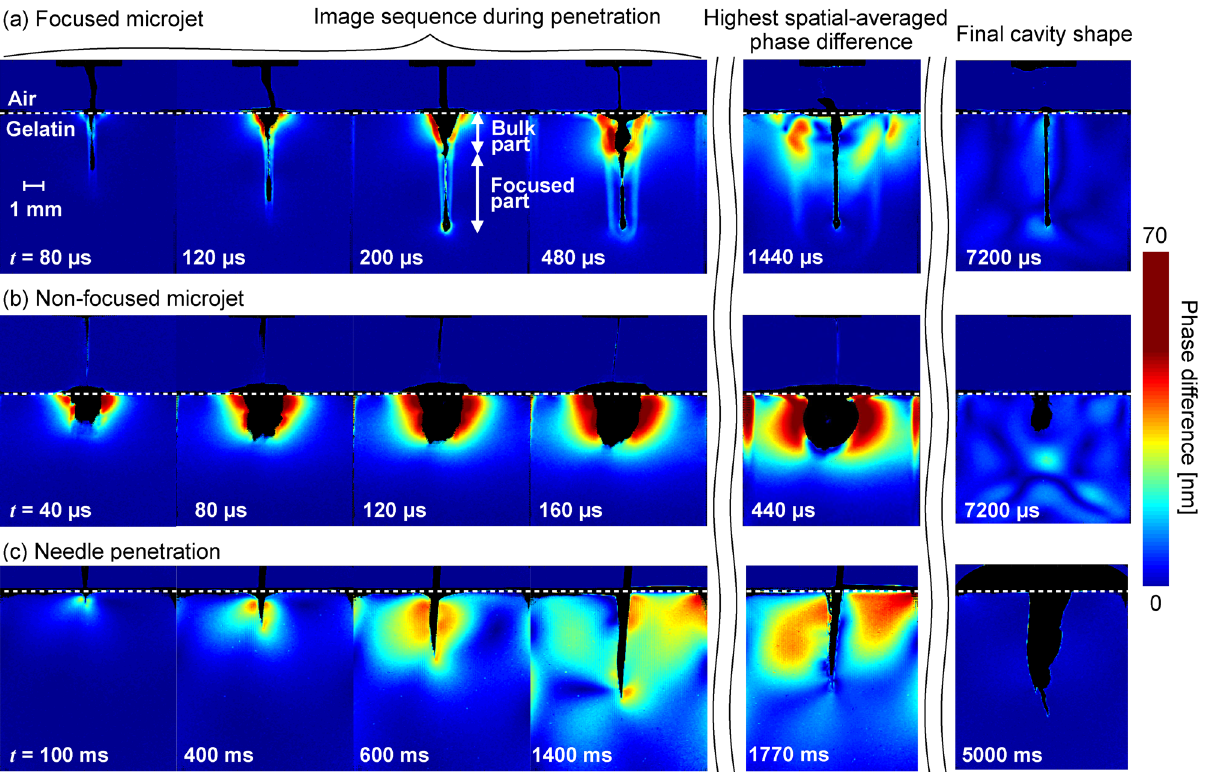
Figure 2. Image sequence of stress fields induced by the penetration of ( a ) the focused microjet, ( b ) the non- focused microjet, and ( c ) the needle. Note that the relative intensity distribution of a phase difference field is proportional to the intensity distribution of a stress